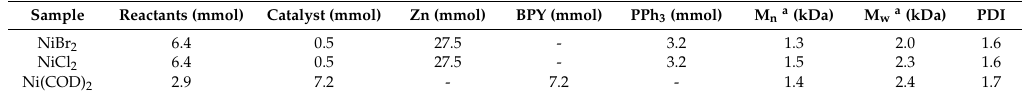
Table 1. Product 1 syntheses and molecular